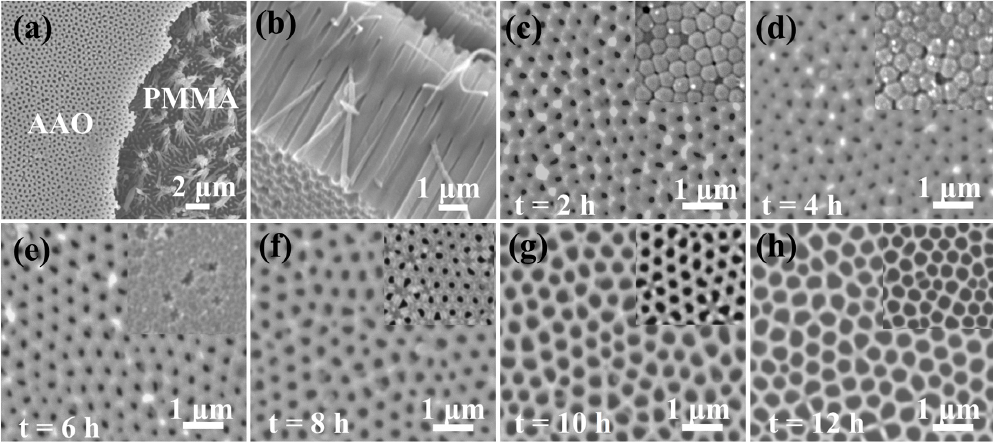
Figure 7. ( a ) Top view of the PMMA/AAO composite film; ( b ) cross-sectional view of the PMMA/AAO composite film; and ( c–f ) SEM images of the PMMA/AAO composite film after different etching times. After removal of the barrier layer, the pore diameter can be further increased by etching in